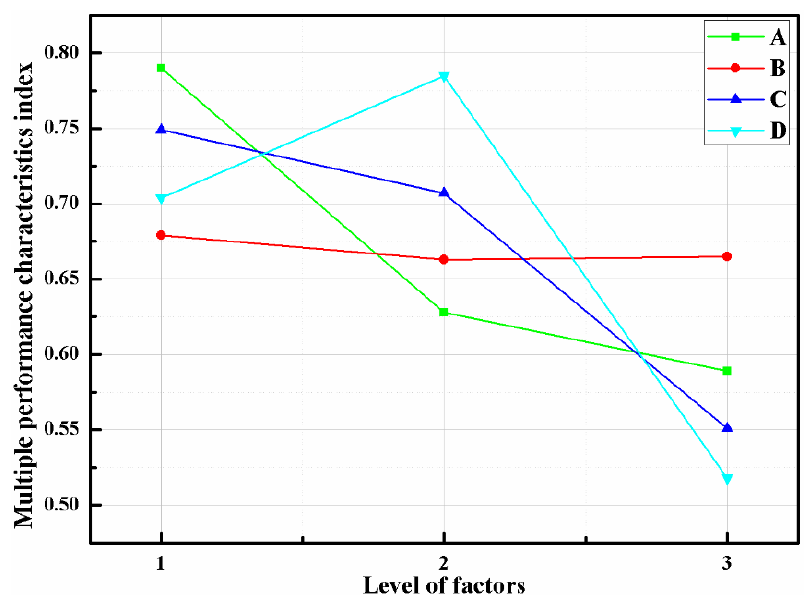
Figure 10. Response graph of the MPCI values with the control factors A (rotation angle β), B (bottom wall height H), C (spacing distance L), and D (hemispherical radius R) at the three level settings. Table 4. Normalization of the different quality characteristics.